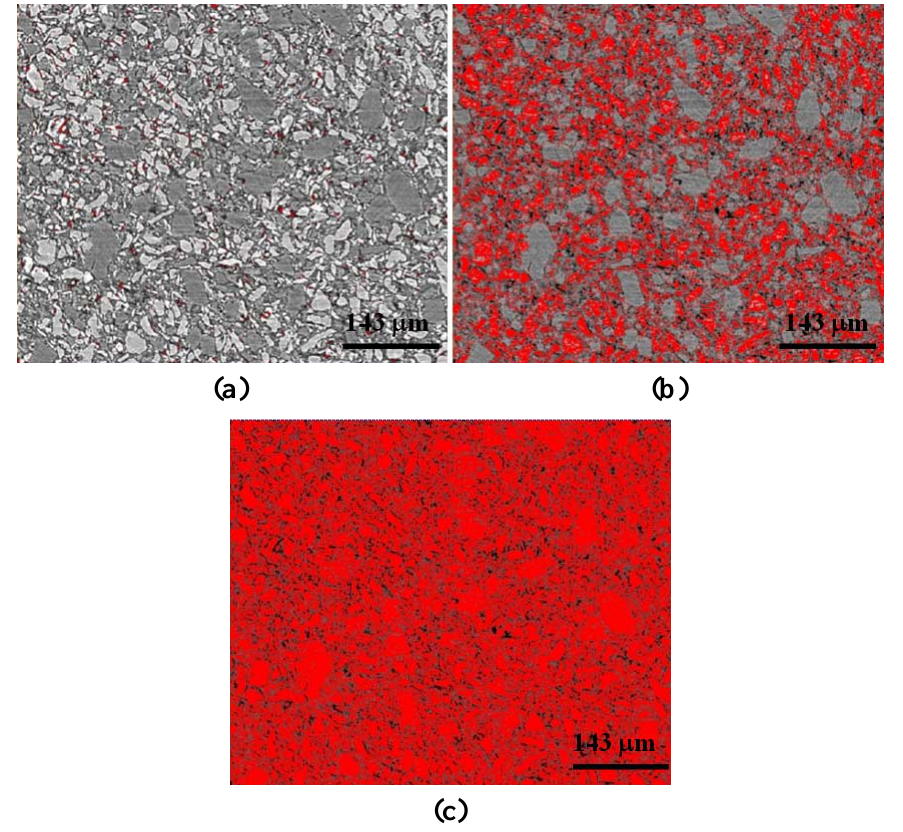
Figure 3. Two dimensional x-z plane slices were used for thresholding. Here the 1:3 LiBH :MgH (uncatalyzed) sample with ( a ) no thresholding; ( b ) red highlighted pixels 4 2 corresponding to thresholding for LiBH ; and ( c ) red highlighted pixels corresponding to 4 thresholding for both LiBH and MgH . Taking the difference in volume computed from 4 2 ( c ) and ( b ), we may determine the volume of MgH . The black areas are air or void space. 2